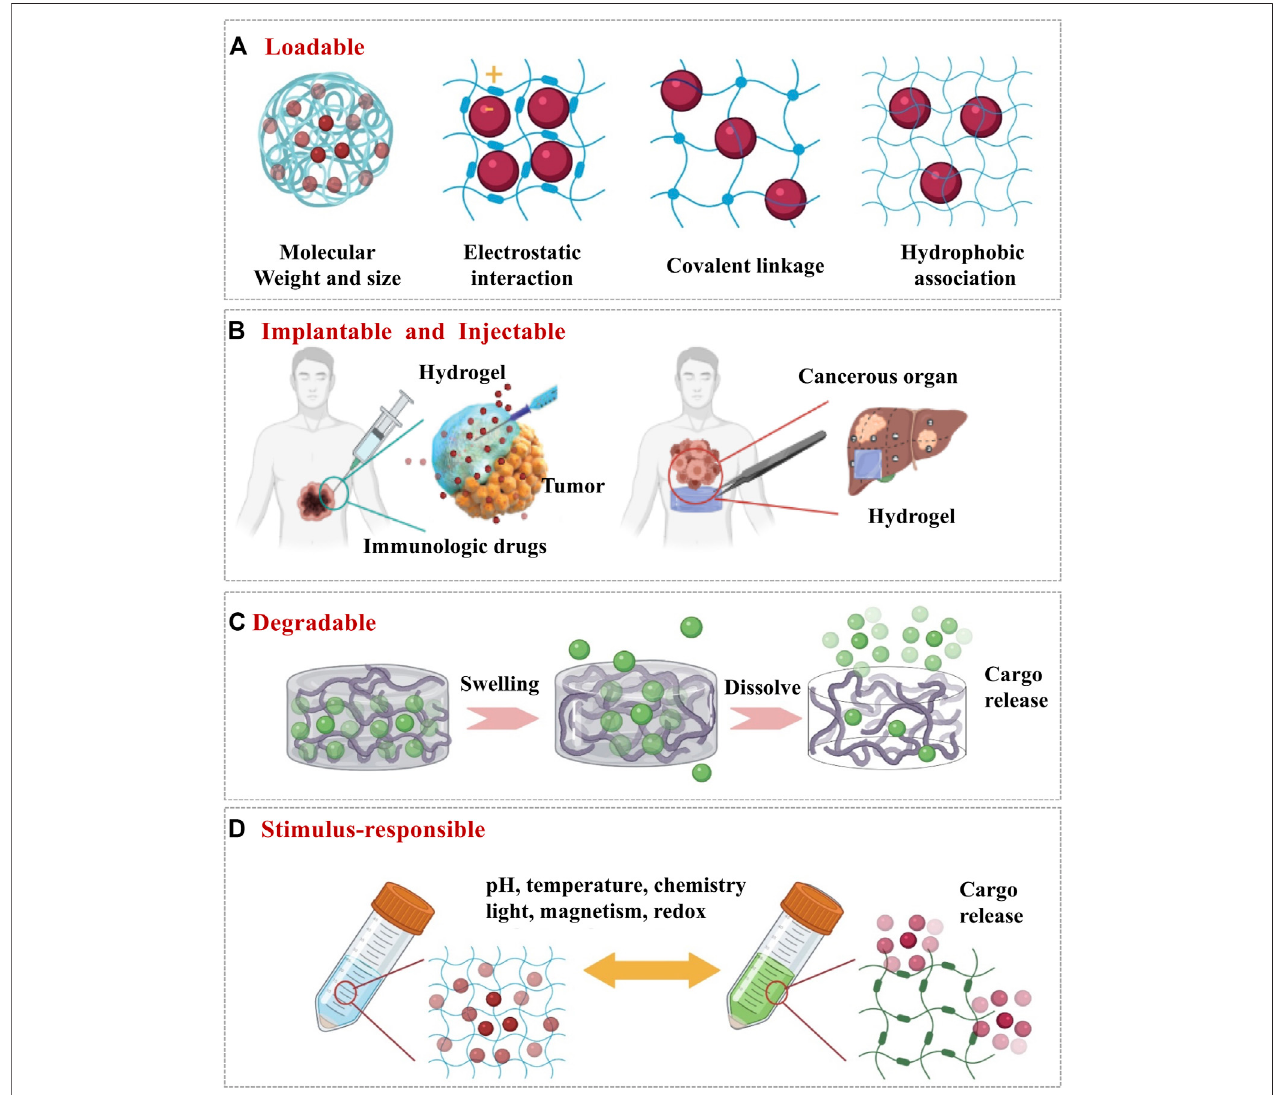
FIGURE2| Thedesignofhydrogelbyalteringitsphysicochemicalpropertiesasdeliverysystemsforcancerimmunotherapy. (A) Loadable:ensurethattheimmune cargo can stay in the hydrogel when it does not need to be released. (B) Implantable and injectable: ensure that the hydrogel can reach the tumor site in a minimally invasive, non-surgical way and stays at the tumor site for drug release. (C) Degradable: hydrogel degrades for releasing the encapsulated drugs. (D) Stimulus- responsible: to achieve controlled release of the drugs from hydrogel upon external stimuli.